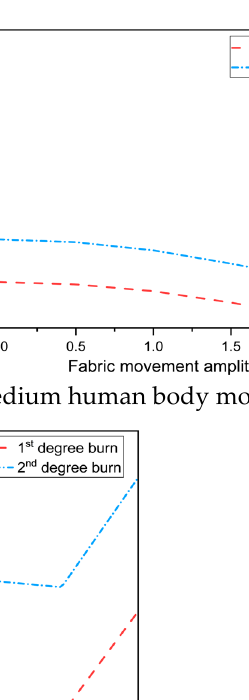
Figure 14. Effect of the human body movement speed on skin burns.